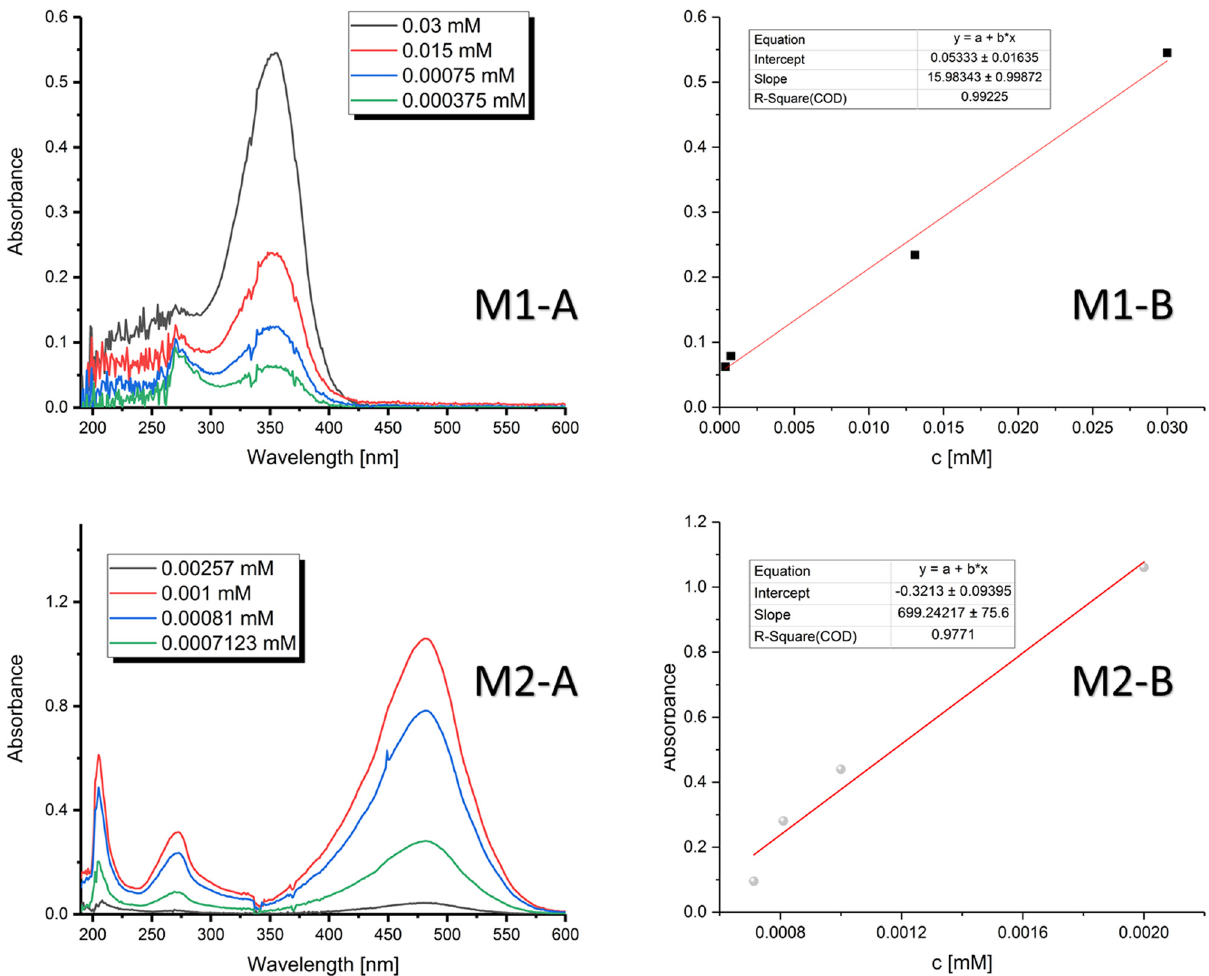
Figure 2: UV - Vis spectra of M1 ( top left ) and M2 ( bottom left ) in acetonitrile. Plots for determination of the extinction coe ffi cients for M1 ( top right ) and M2 ( bottom right )